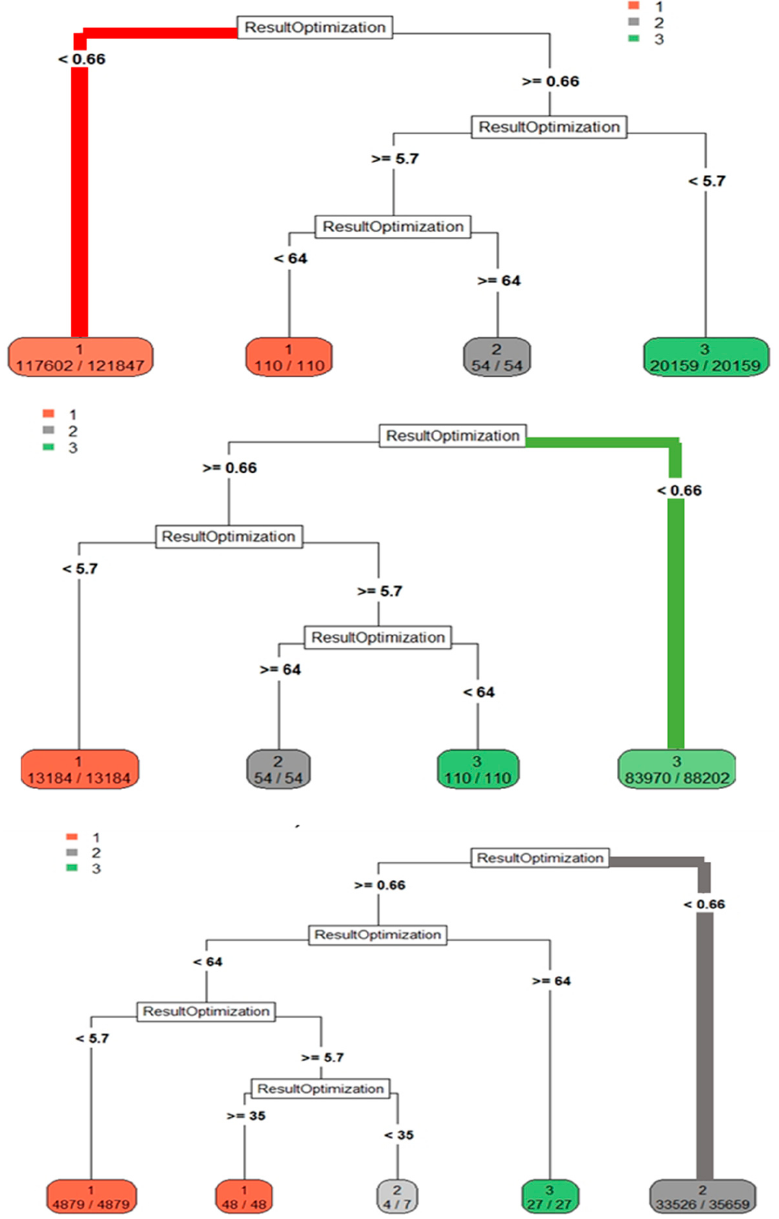
Figure 11. Decision tree. Results for Consumers 3 and 5.